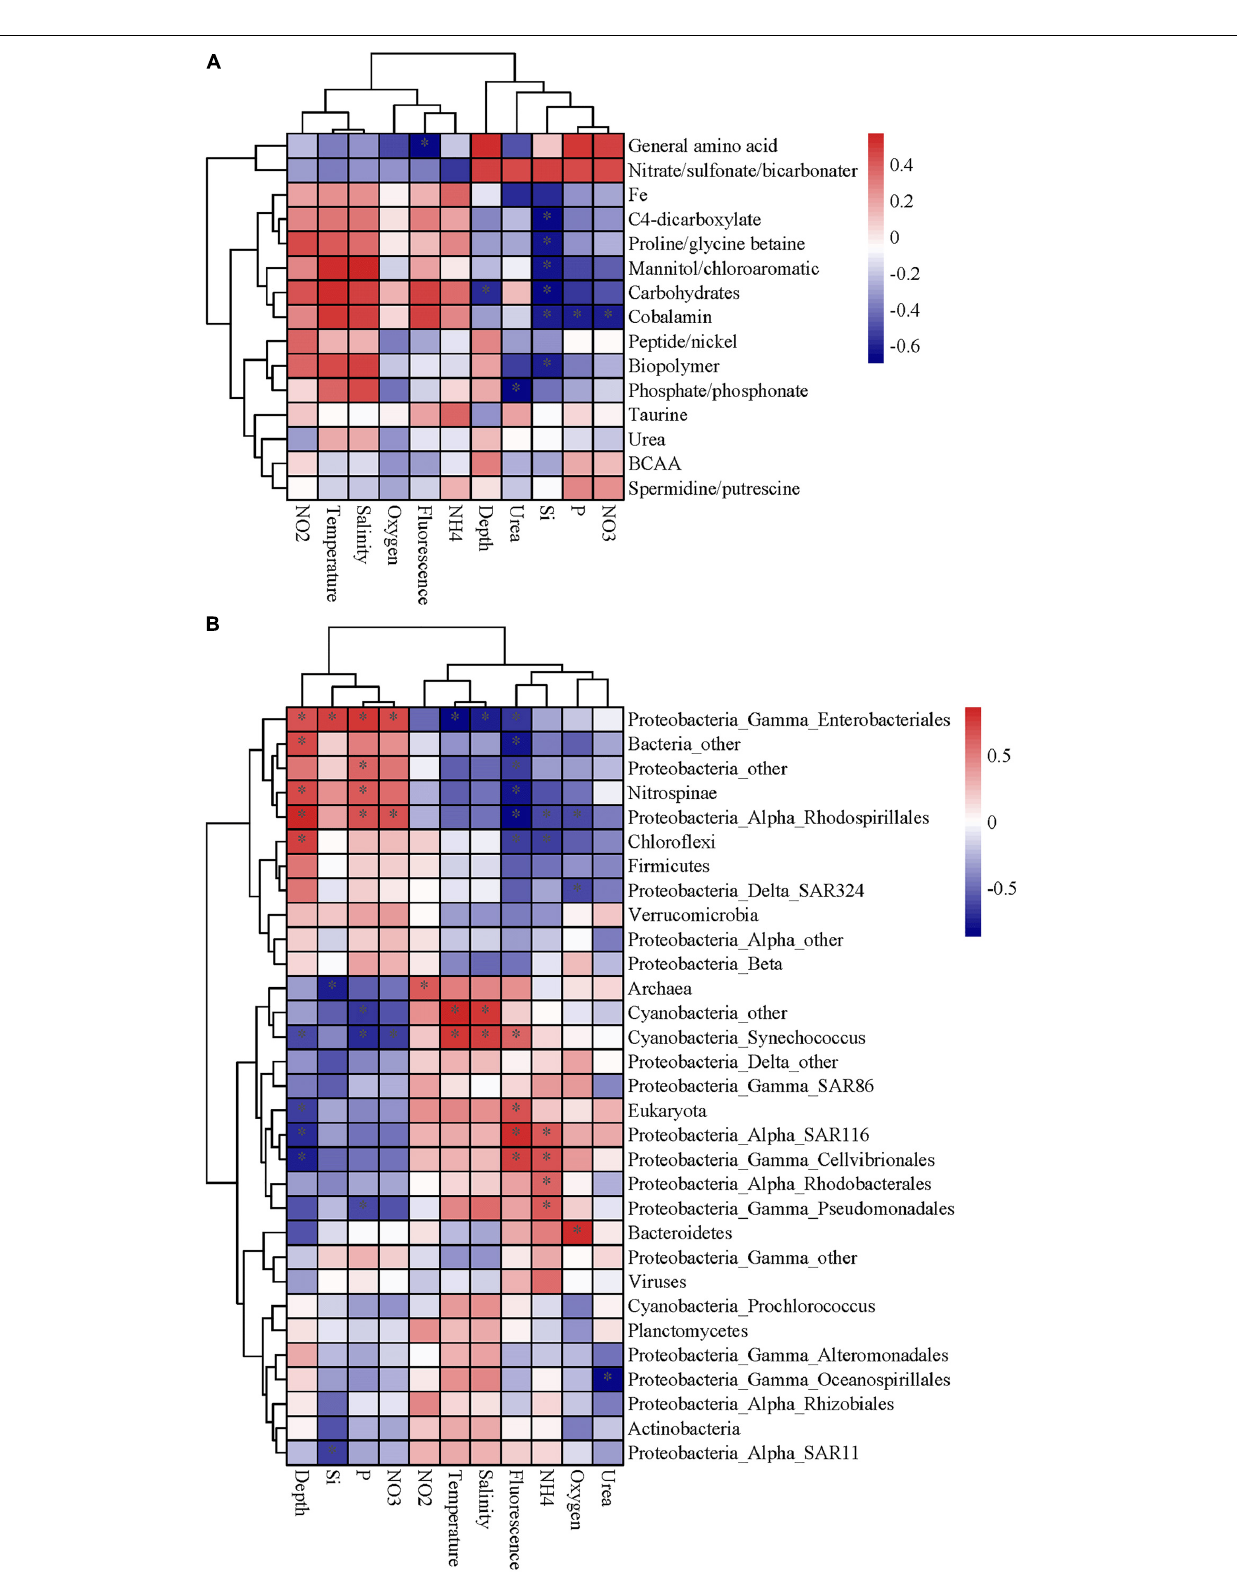
Frontiers in Microbiology |